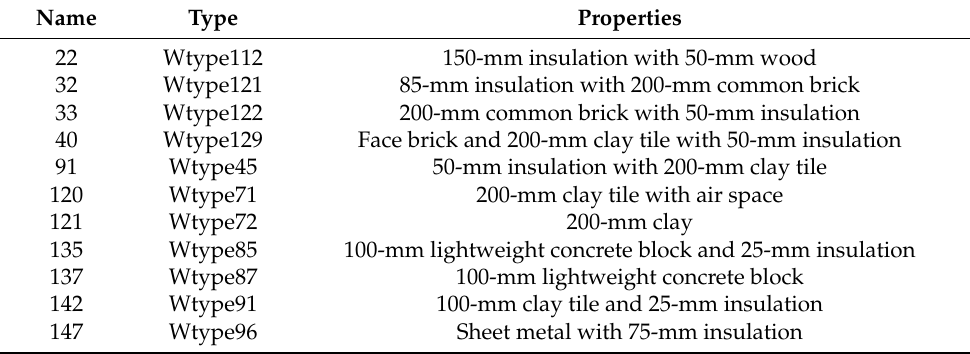
Table 1. Different employed type of walls for modeling greenhouses.